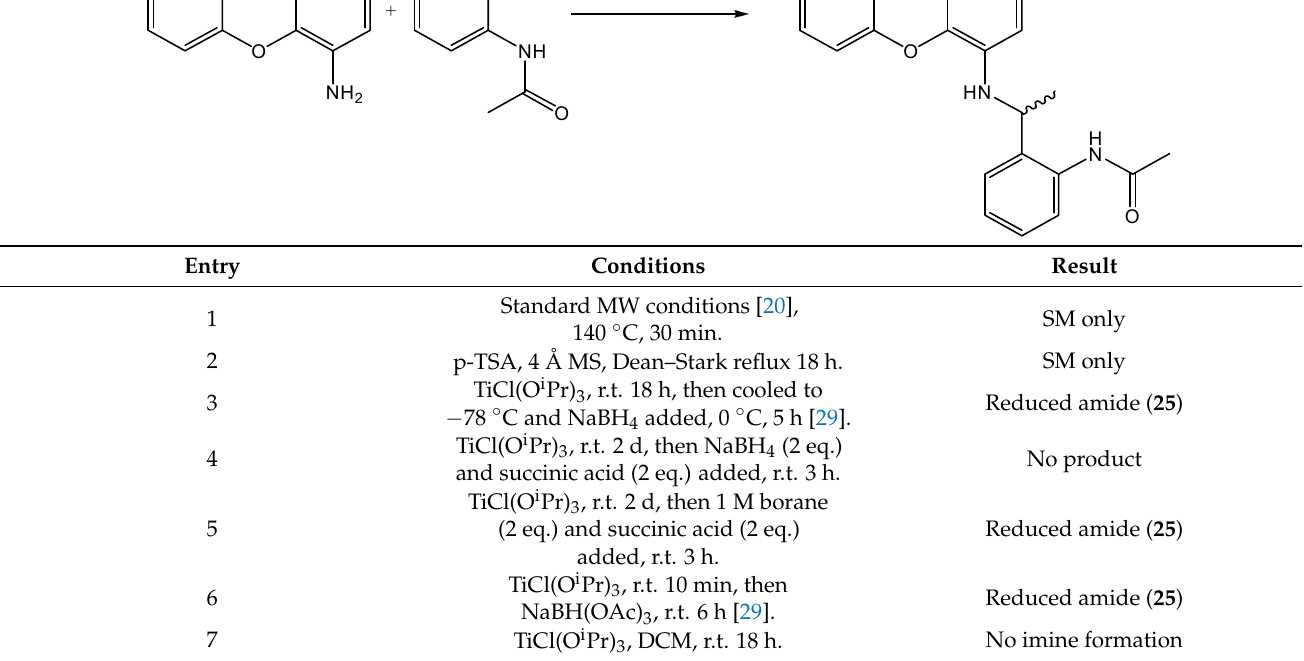
group. Attempts to control this reaction, by using different reagents or temperatures, were the reduced amide as before ( 25 , Entries 4–6). Table 5. Reductive amination conditions investigated. SM, starting